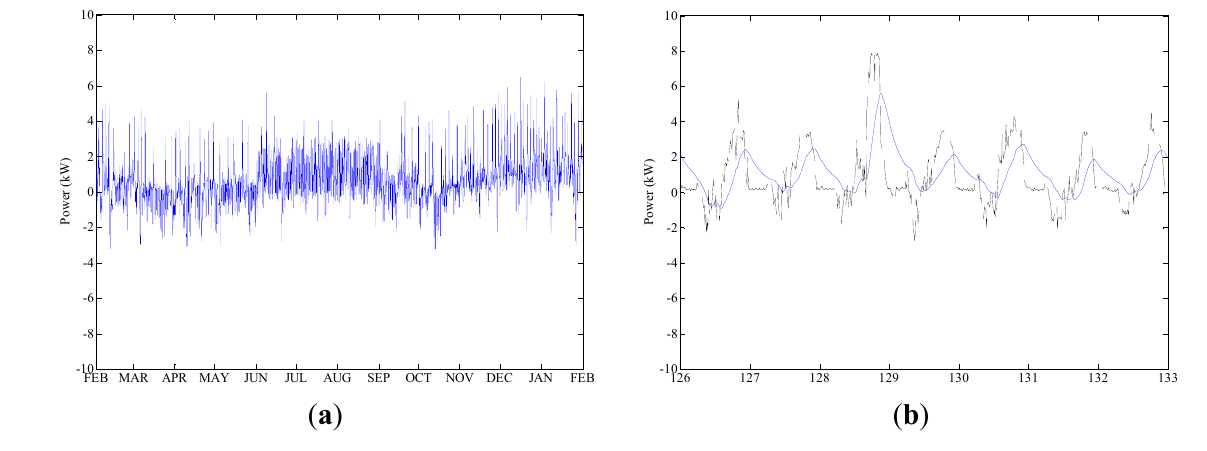
Figure 5. Resulting power profile at the point of common couple (PCC) after applying the simple moving average strategy: ( a ) during a year and ( b ) during the Week 19 (in blue) superimposed to the net power profile (black dashed